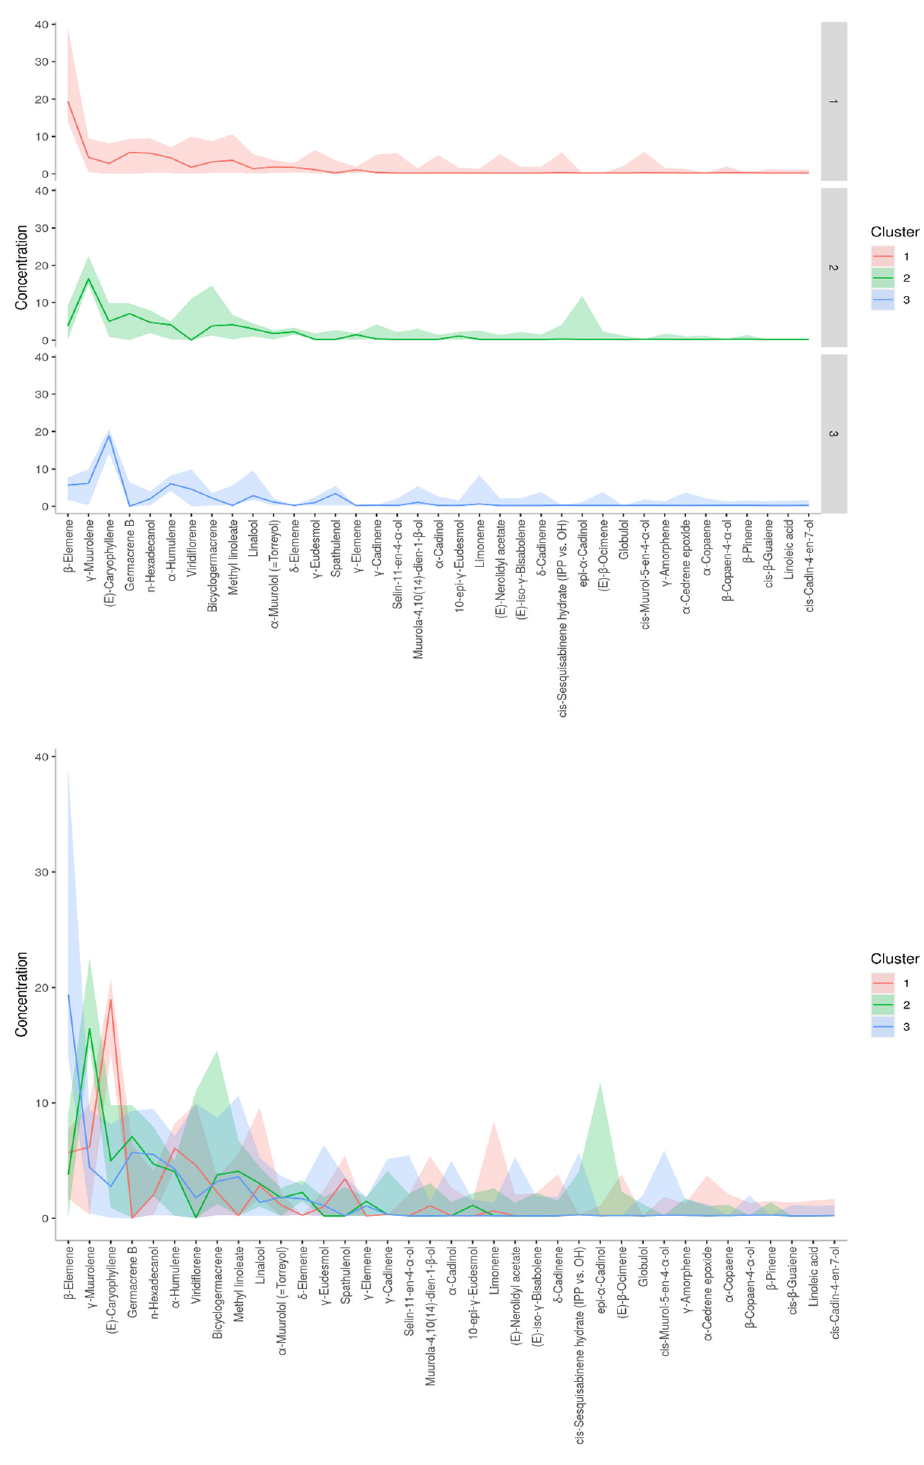
Figure 3. K-means cluster analysis. The X-axis represents phytoconstituents and the Y-axis represents its relative intensities. The median intensities of corresponding clusters are shown in different colored lines.